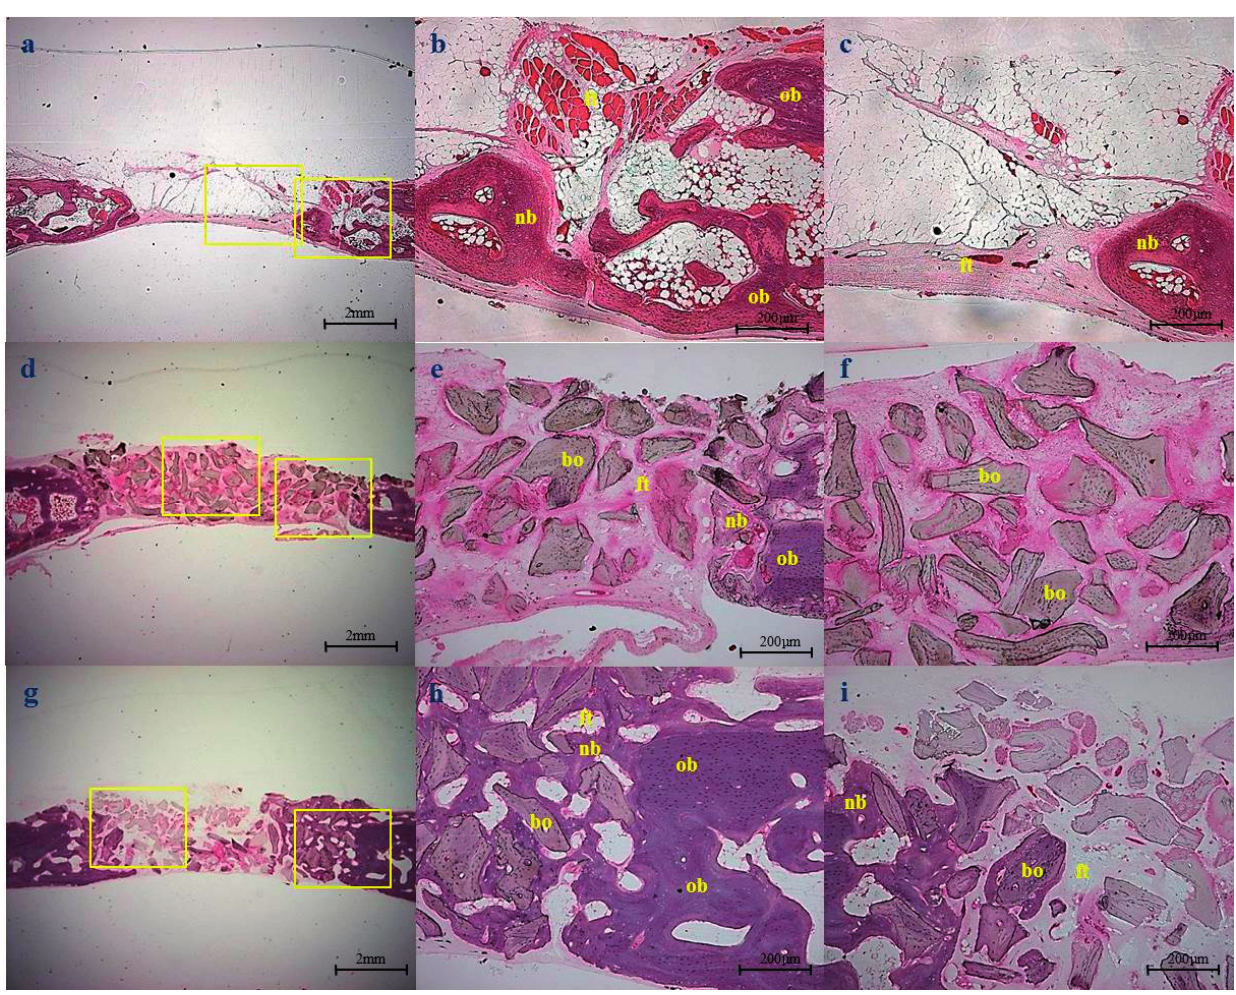
Figure 7. Histologic sections obtained at four weeks after surgery: ( a – c ) The non-implanted control group, showing new bone (nb) formation from the cut edge; ( d – f ) Bio-Oss ® group; ( g – i ) BMP-2/Bio-Oss ® group. New bone was of better quality than in the Bio-Oss ® group. Original magnifications were ×12.5 for ( a , d , g ) and ×40 for the others. (nb: new bone, ft: fibrovascular tissue, bo: Bio-Oss ® particle, ob: old bone). The enlarged pictures of the yellow boxes are in the middle and right